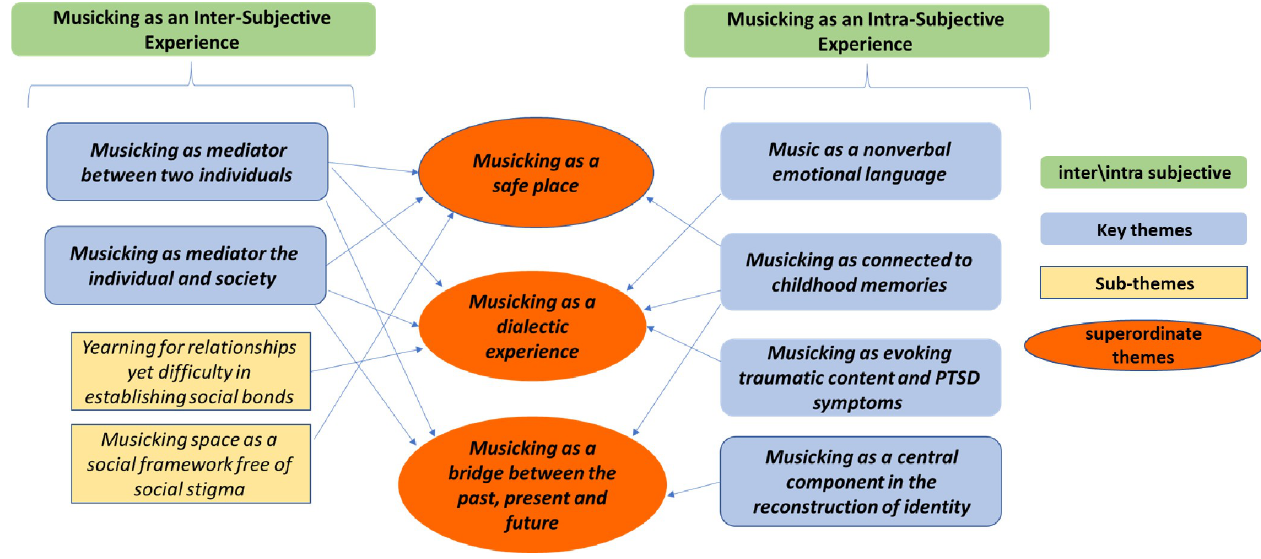
Fig 1. Relationships between